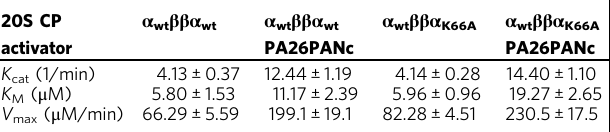
Table 1 Summarization of the k cat (1/min), K M ( μ M), and V μ M/min) of LFP peptide degradation by symmetric max ( and asymmetric 20S CP without and with